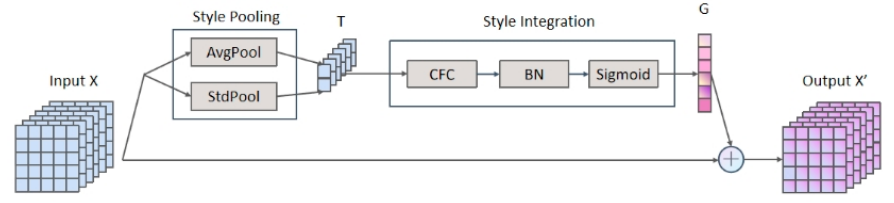
Figure 1. SRM structure